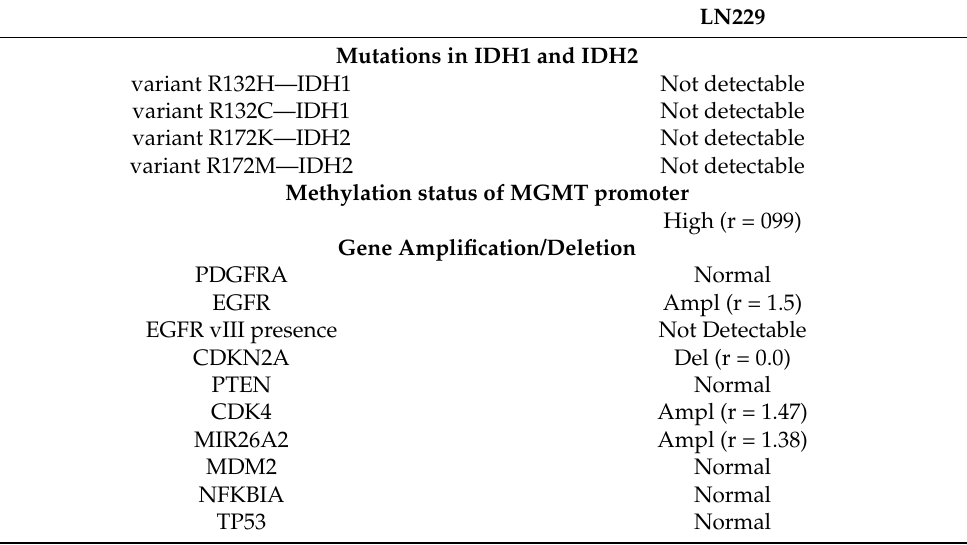
Table 2. LN229 genotyping using MLPA. Molecular markers with clinical importance were